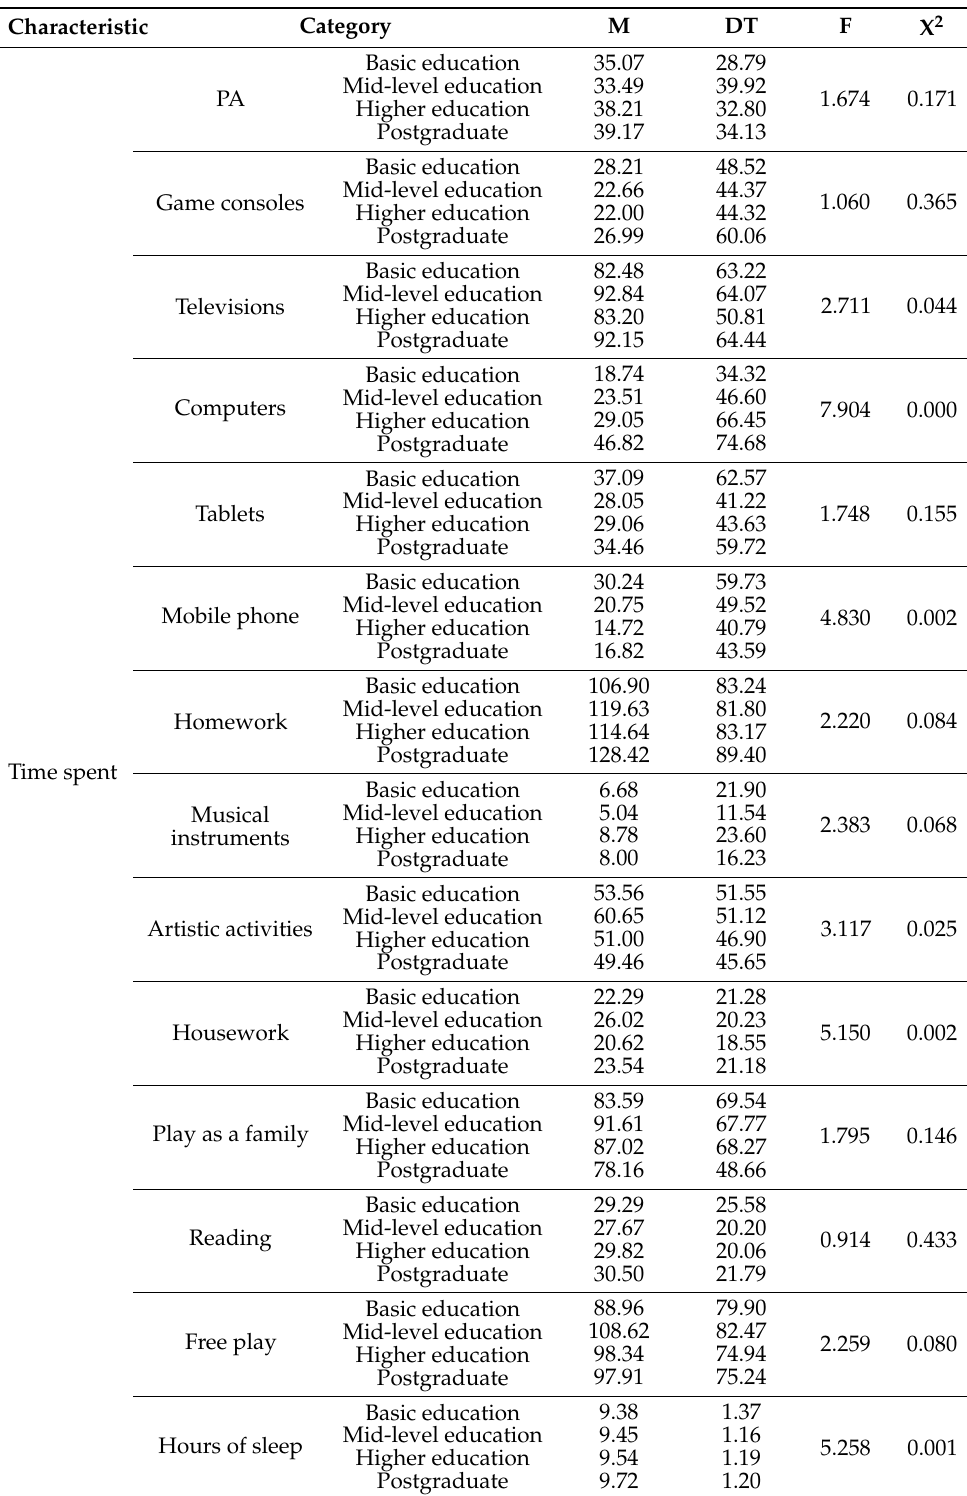
Table 7. Time of use of technological devices and daily actions (expressed in minutes) during confinement according to the educational level of European